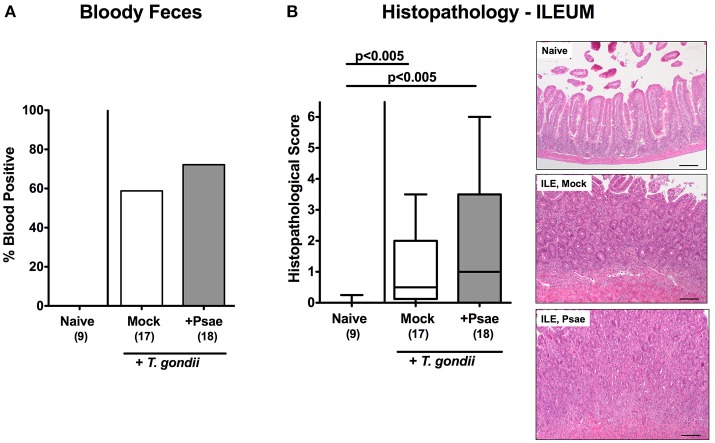
Clinical and histopathological sequelae following peroral MDR P. aeruginosa challenge of mice with a human gut microbiota suffering from subacute ileitis. At day 5 following subacute ileitis induction, mice with a human gut microbiota were either perorally challenged with MDR P. aeruginosa (+Psae, dissolved in PBS) or with PBS alone (Mock). Uninfected mice with a human gut microbiota but without ileitis served as control animals (Naive). Clinical and microscopic intestinal changes were assessed 96 h following Psae challenge. (A) Abundance of blood was determined in fecal samples by the Guajac (Haemoccult) method. Cumulative blood positivity rates were calculated from four independent experiments. (B) Histopathological changes were determined in H&E stained ileal paraffin sections applying a standardized scoring system (see methods) and representative photomicrographs depicted (right panel; 100x magnification, scale bar 100 μm). Box plots represent the 75th and 25th percentiles of the median (black bar inside the boxes). Total range and significance levels determined by one-way ANOVA test followed by Tukey post-correction test for multiple comparisons are shown. The total numbers of analyzed animals are given in parentheses. Data were pooled from four independent experiments.